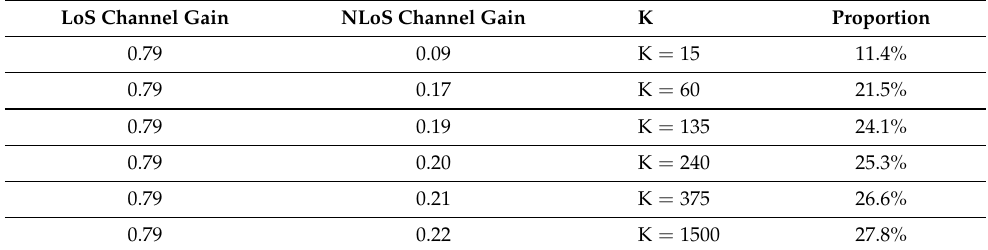
Table 2. Numerical values of LoS and NLoS links with different K.